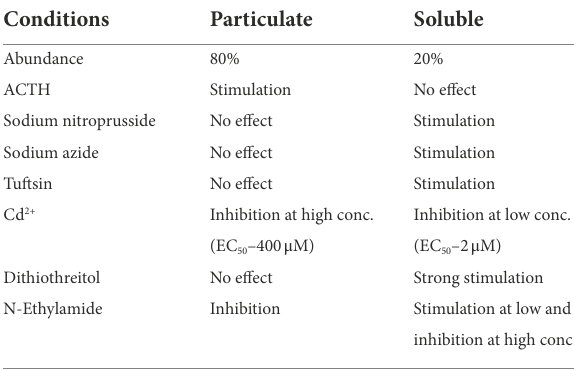
TABLE 1 Summary of the properties of particulate and soluble guanylate cyclase of rat adrenocortical tissue (from Sharma, 2002).